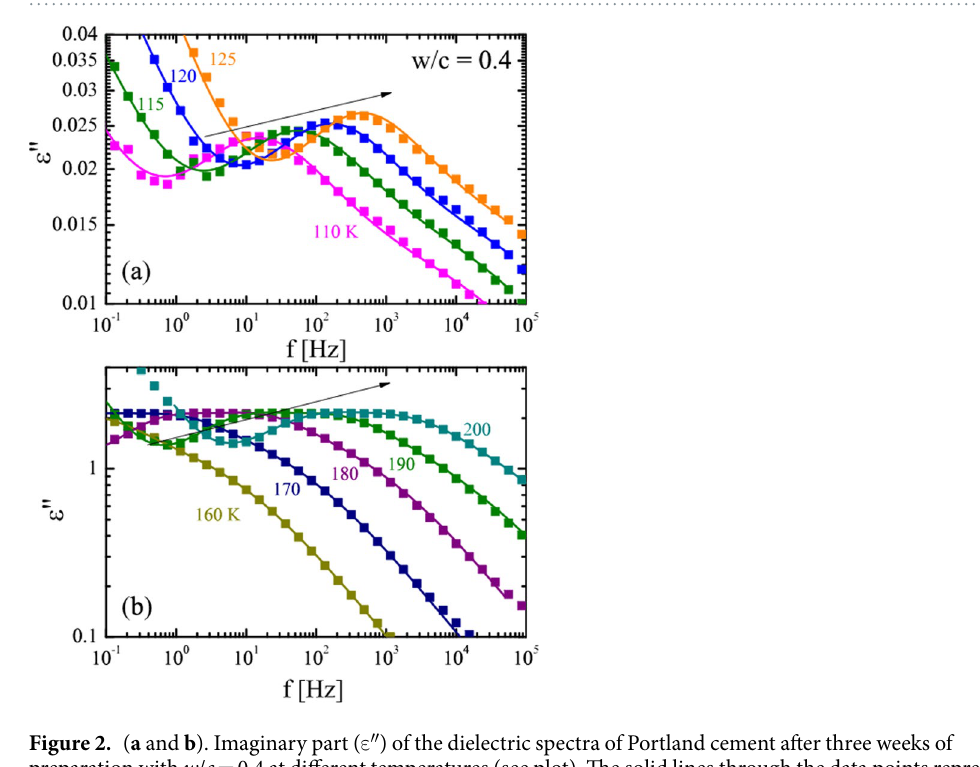
Table 2. Activation Energy ( E a ) and Pre-Exponential Factor (log ( τ o )) obtained from the Arrhenius equation applied to the data in Fig. 4.